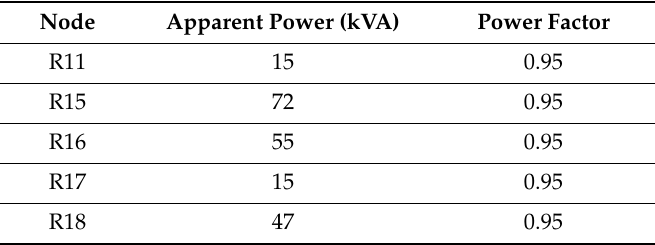
Table 2. CIGRE LV distribution network: three-phase-loads & Power Factor (P.F) at each